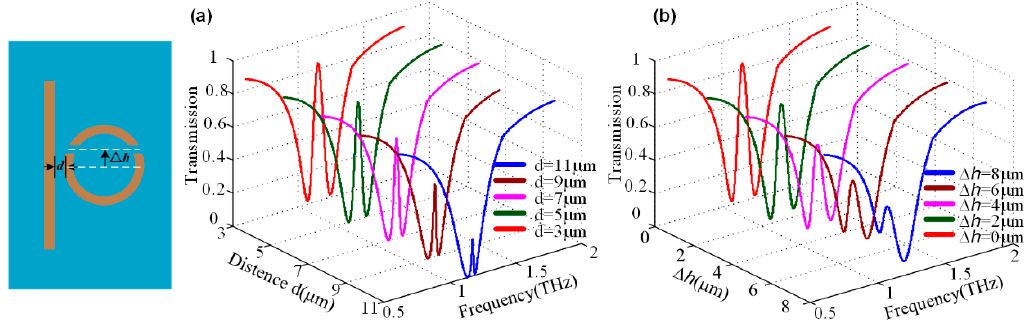
Figure 4. Transmittance spectra of arrays ( a ) with different separation distance between ‘bright’ and ‘dark’ resonators and ( b ) with different vertical distance of the split gap △ h. A schematic diagram of the sample is shown on the left.